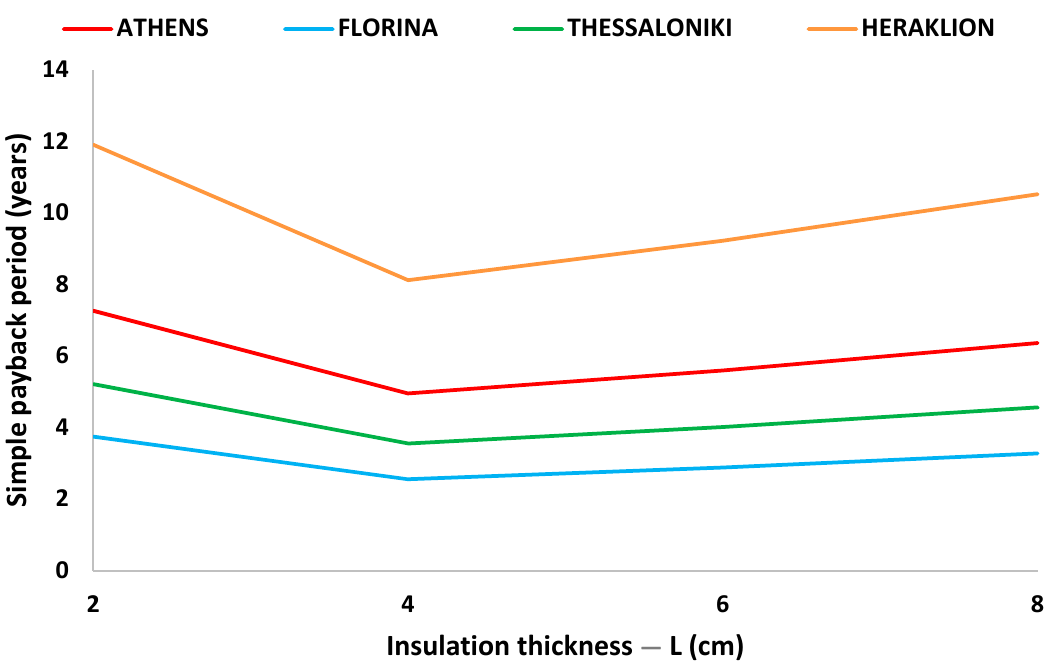
Figure 8. Simple payback period for the examined cases with insulation.